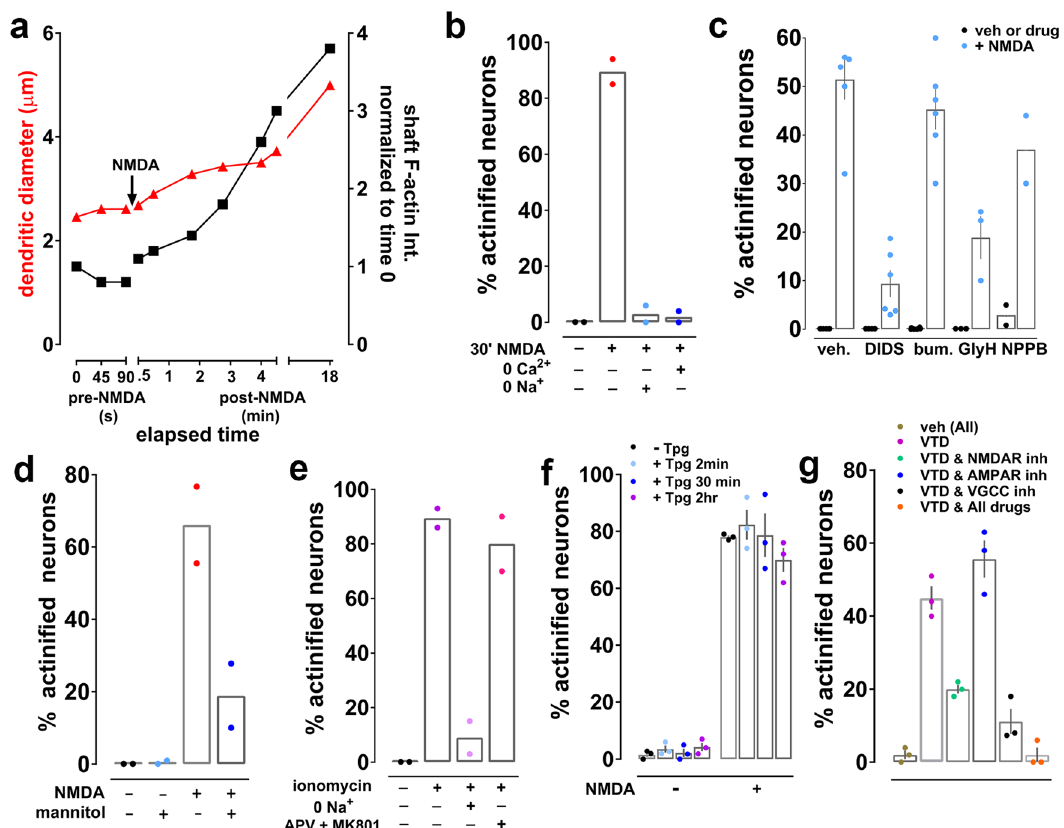
Fig. 4 | Actini fi cation is triggered during cell swelling. a Simultaneous quanti fi - cation of dendrite diameter (red triangles) and F-actin intensity (black squares) in anindividualneuron following additionof NMDA atthe indicated time. b Removal of either extracellular sodium or calcium prevents NMDA-induced actini fi cation. n =2 independent experiments; unpaired t test, two tailed ( p =0.0039, NMDA vs NMDA w/ zero Na + ; p =0.0032, NMDA vs NMDA w/ zero Ca 2+ ). c Effect of various chloride fl ux inhibitors on NMDA-induced actini fi cation. n =5 (veh; DIDS; bum); 3 (GlyH); 2 (NPPB) independent experiments. Two-way ANOVA [( − ) NMDA vs (+) NMDA, F (1, 36)=230.8; p <0.0001; all drugs, F (4, 36)=0.1954, p <0.0001]. d Mannitol inhibits NMDA-induced actini fi cation. n =2 independent experiments; two-wayANOVA[( − )NMDAvs (+)NMDA, F (1, 4)=11.85; p =0.0262;( − ) mannitolvs (+)mannitol, F (1,4)=11.41, p =0.0279],withTukey ’ sposthocmultiplecomparison